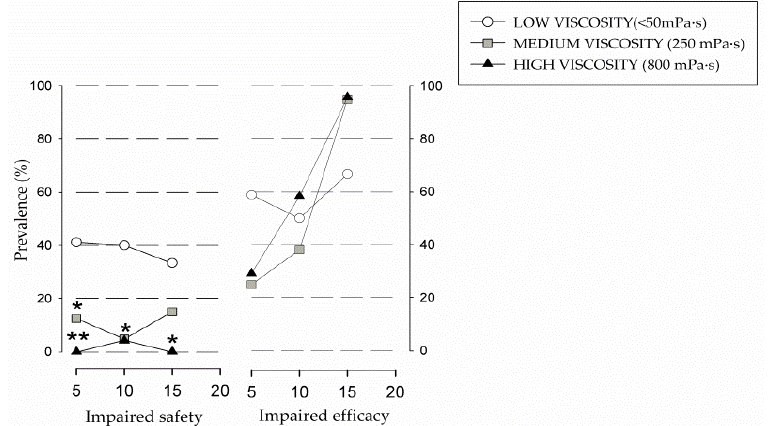
Figure 2. Prevalence of patients with impaired efficacy and safety of swallow according to the different levels of viscosity of the Volume Viscosity Swallowing Test (V ‐ VST). * p < 0.05, ** p < 0.01 vs. liquid. Effect of volume on efficacy impairment GLM ( p < 0.001 medium viscosity; p = 0.070 liquid; p < 0.001 high viscosity. Effect of volume on safety impairment GLM ( p = 0.083 medium viscosity; p = 0.178 liquid; p —high viscosity). GLM: general linear model.